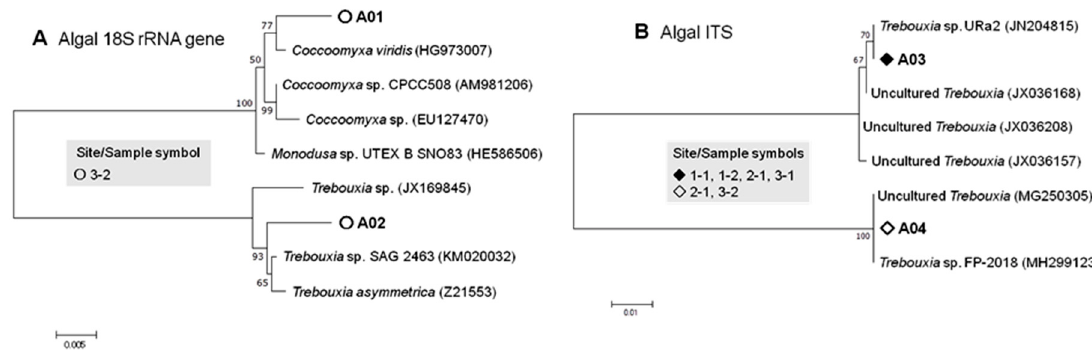
Figure 4. Phylogenetic trees of 18S rRNA genes ( A ) and ITS regions ( B ) of the lichen-associated algal